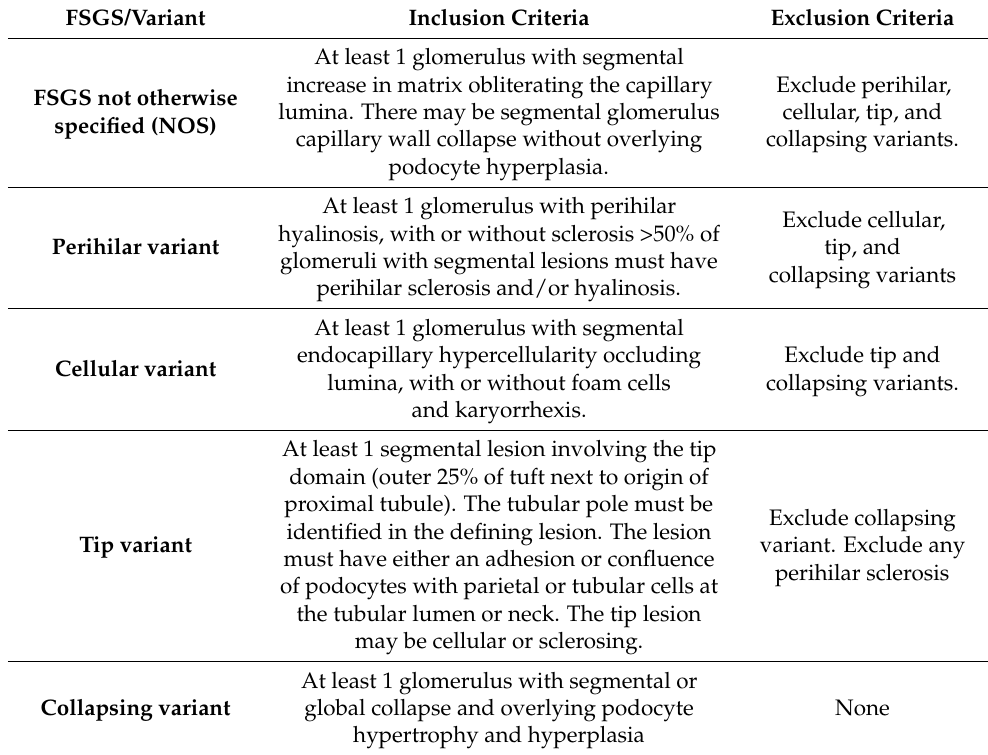
Table 1. The Columbia classification of FSGS.